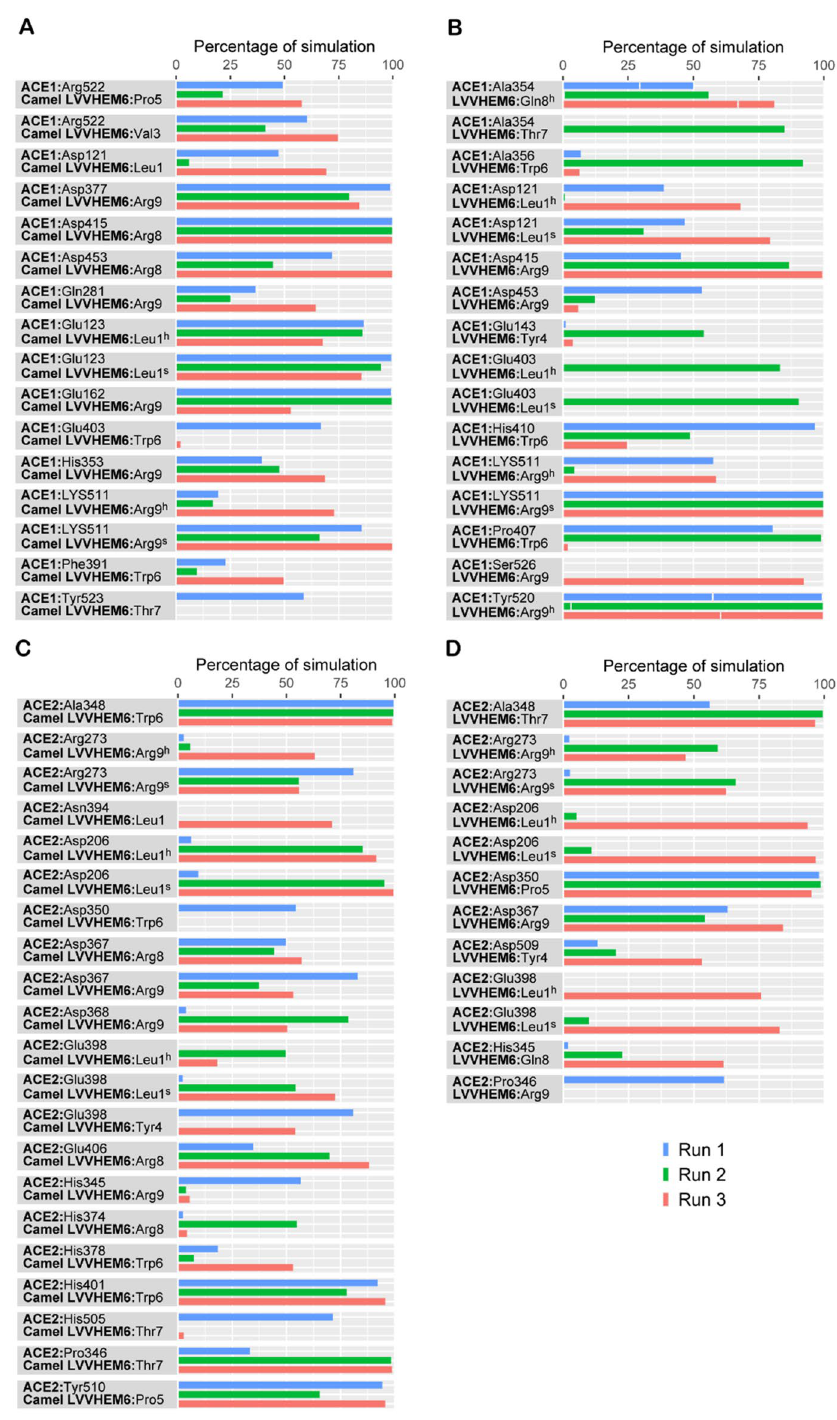
Figure 6. Percentage of contact time during which intermolecular polar contacts were retained between ACE1 and ACE2 and hemorphin peptides in the 500 ns systems. ( A ) Camel LVVHem6 with ACE1 ( B ) LVVHem6 with ACE1 ( C ) Camel LVVHem6 with ACE2 ( D ) LVVHem6 with ACE2. Here, h signifies a hydrogen bond and s signifies a salt